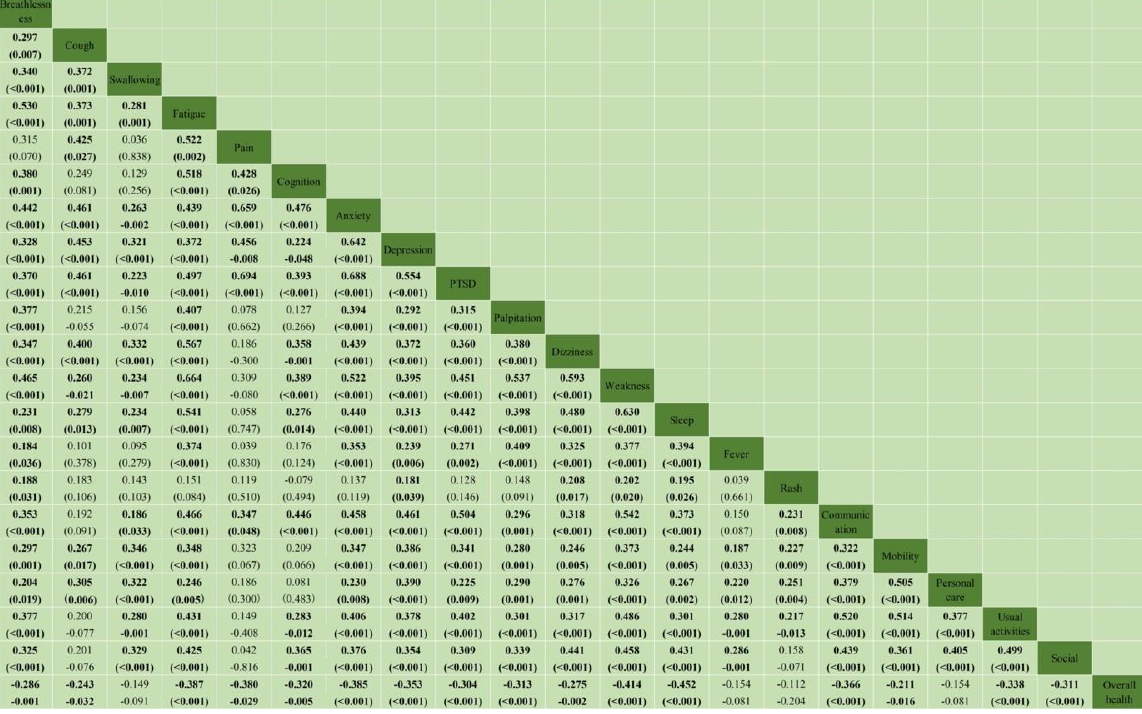
Figure 3. The correlation between symptom severity, functional disability, and overall health. Notes: All correlation was described as Spearman’s rank correlation coefficient (rs) and p -value. rs ( p -values) with bold indicated statistically significant correlations; PTSD: Post-traumatic stress dis- orders.